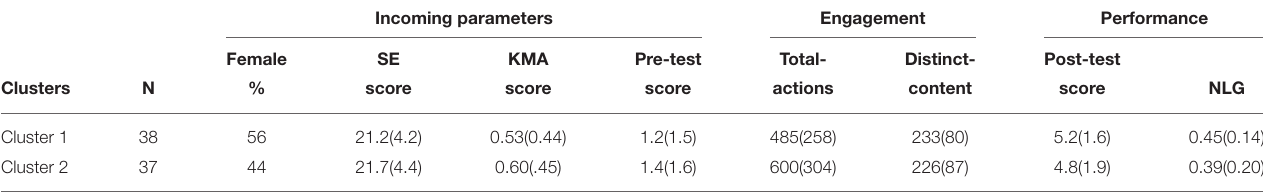
TABLE 5 | Summary of the incoming parameters, engagement and performance measures for the discovered clusters. Incoming parameters